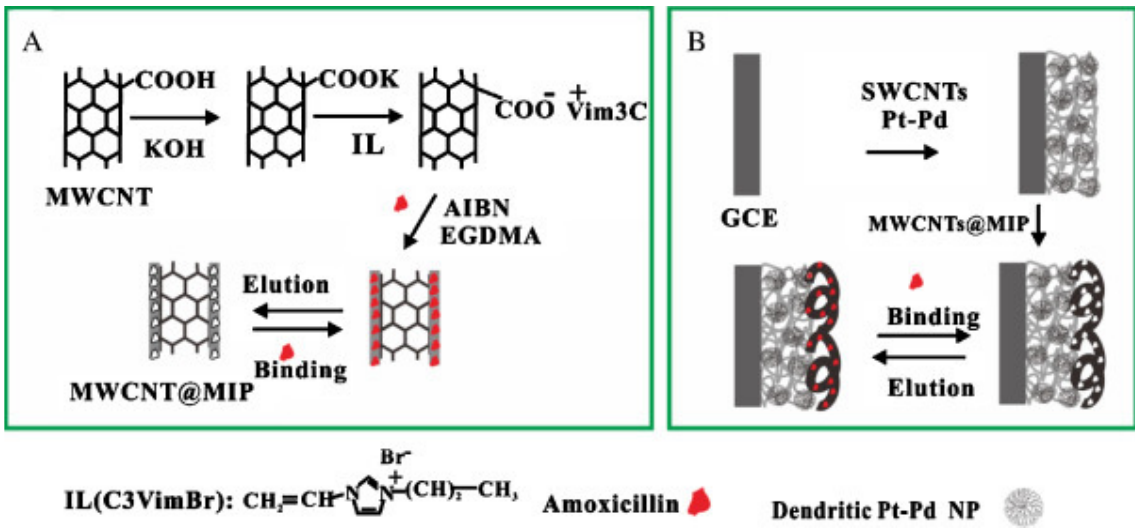
Figure 7. Fabrication protocol for amoxicillin MIP-based sensor using a combination of ( A ) MWCNT, ( B ) SWCNT, nanoparticles and ionic liquid, for sensitivity enhancement. Reprinted with permission from [167]. Copyright 2015